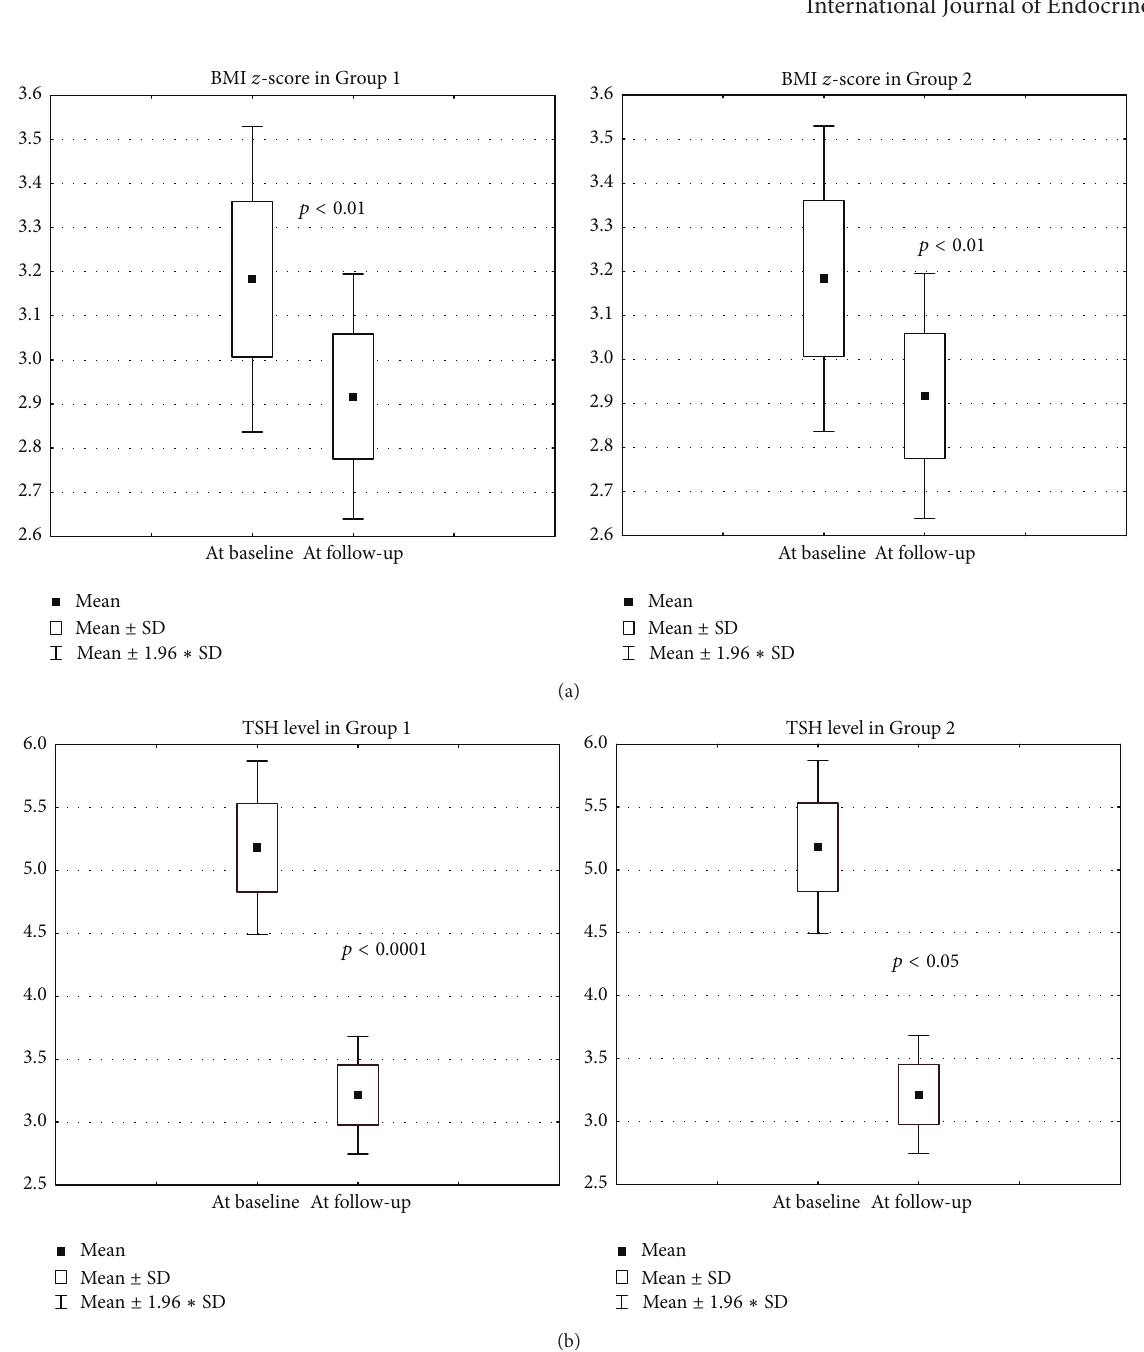
was found in terms of BMI SDS, both at the study entry and after 24 months. In spite of the apparent increase of BMI SDS observed in treated children during the 2-year follow-up, the percentage of overweight subjects remained stable in this group. In 42 children who normalized TSH after LT4 therapy withdrawal, there was no difference in BMI evolution during the entire treatment